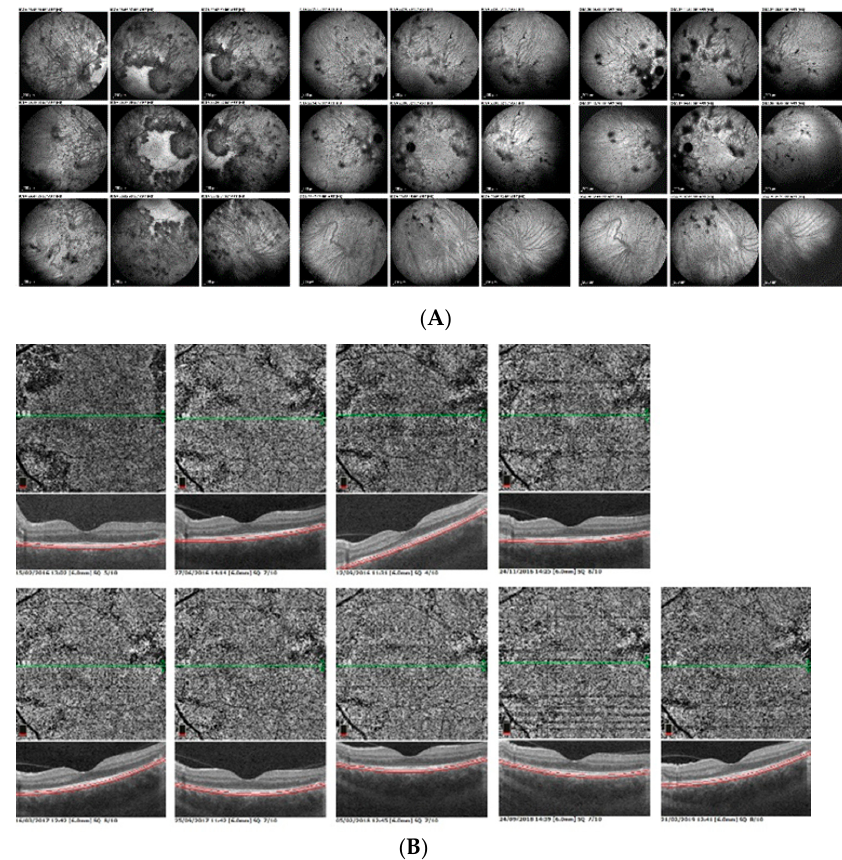
Figure 5. Tuberculosis ‐ related SC. ICGA versus OCT ‐ A. This patient’s lesions were mostly outside the macula. Therefore, ICGA ( A ) was much more precise for follow ‐ up and treatment monitoring ( A ), whereas OCT ‐ A ( B ) only showed evolution of the rare central lesions ( B ).